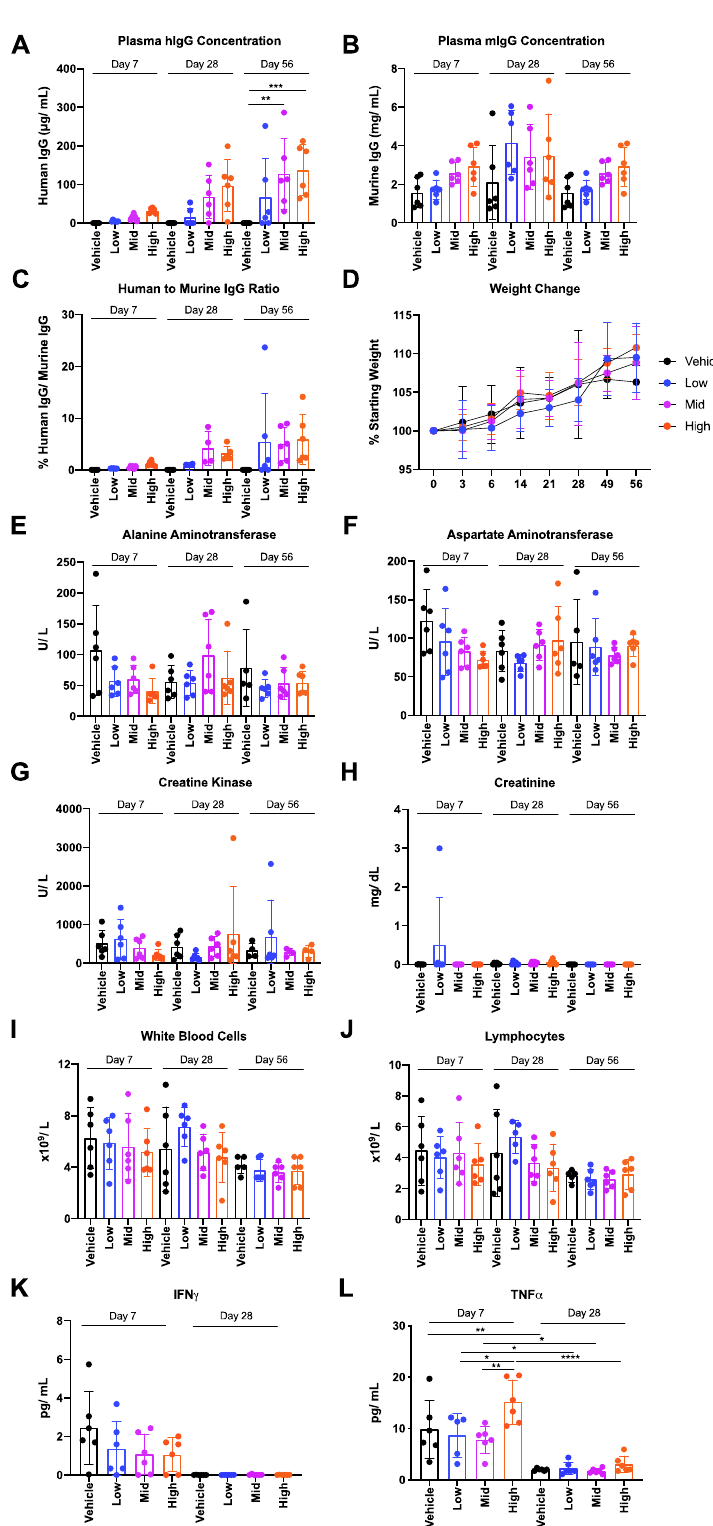
Figure 2. Findings of the murine AAV6.2FF-31C2 safety and tolerability study. 6-week-old male and female BALB/c mice ( n = 6; equal male and female mice per group) were administered either a low (1 × 10 11 VG), mid (2 × 10 11 VG) or high (6 × 10 11 VG) dose and sacrificed either 7-, 28- or